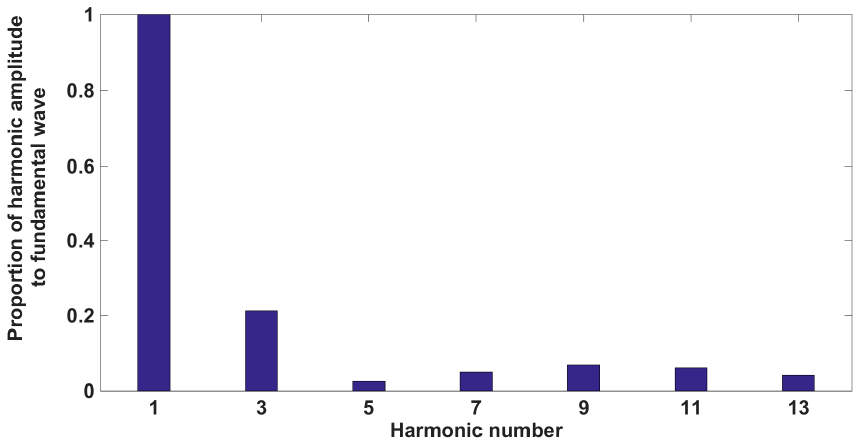
Figure 8. The ratio of the air gap magnetic density harmonic wave to the base wave in the no-load condition. load